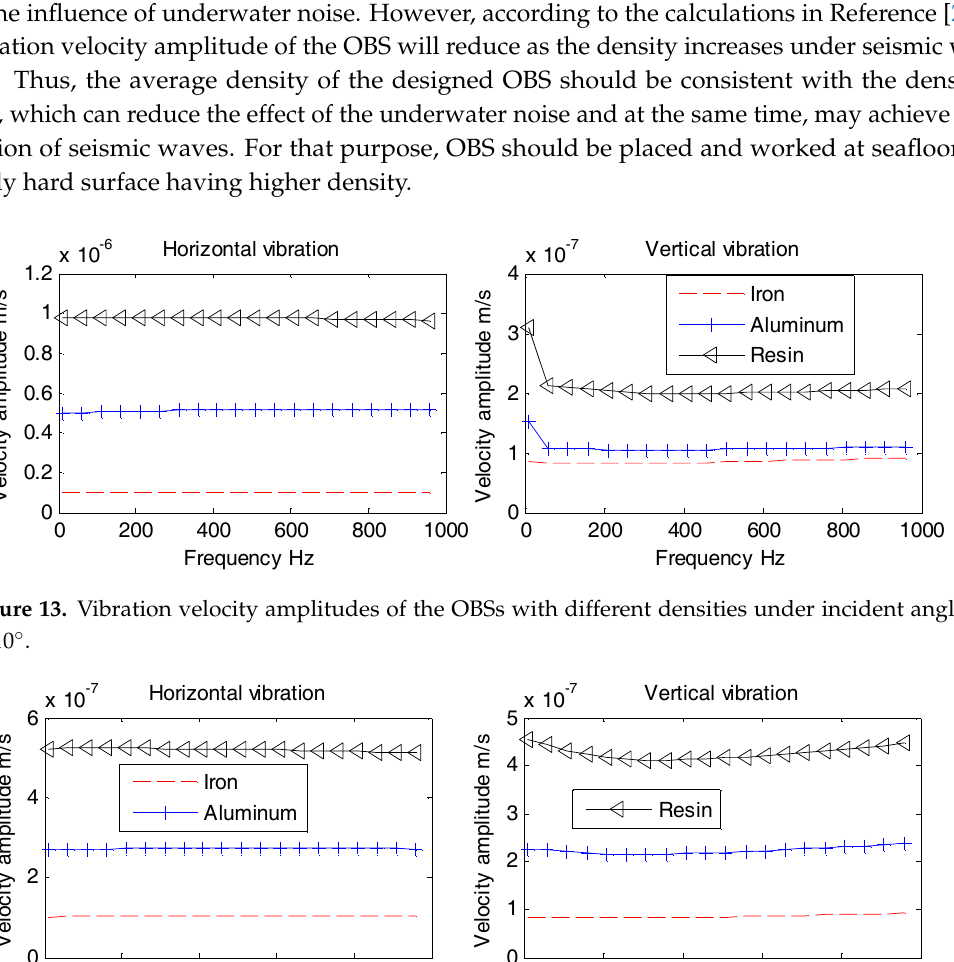
Figure 15. Vibration velocity amplitudes of the OBSs with different densities under incident angle of 90°.